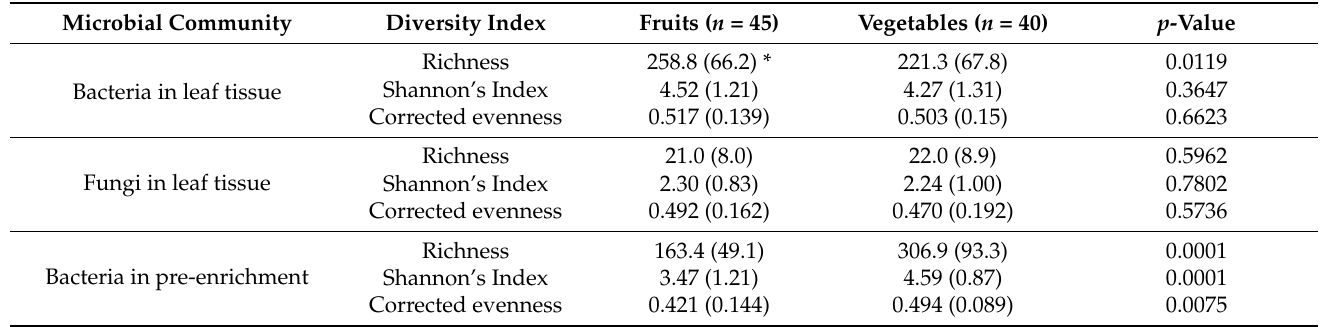
Table 2. Alpha diversity indices of microbial communities in samples of leafy vegetables and berry fruits as compared by one-way